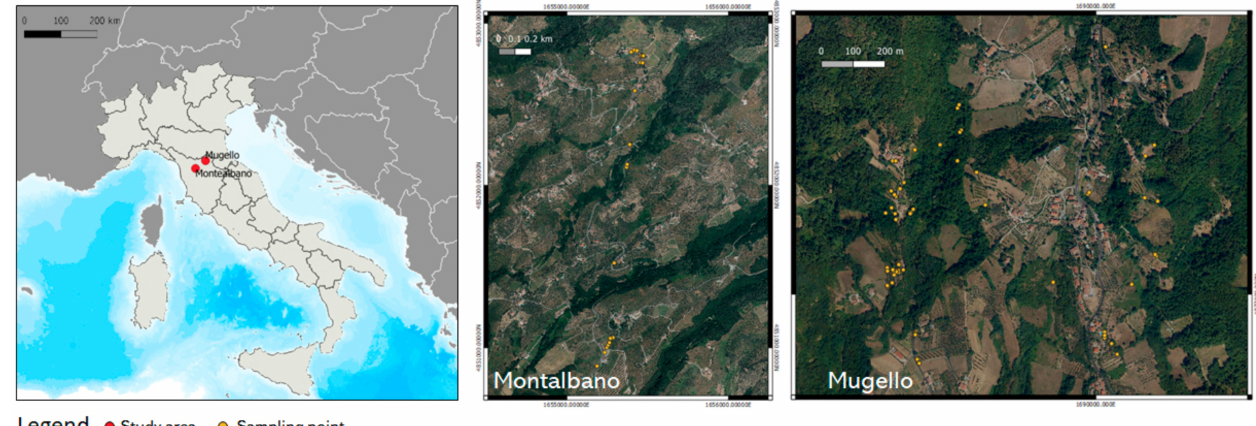
Figure 1. Location of the study